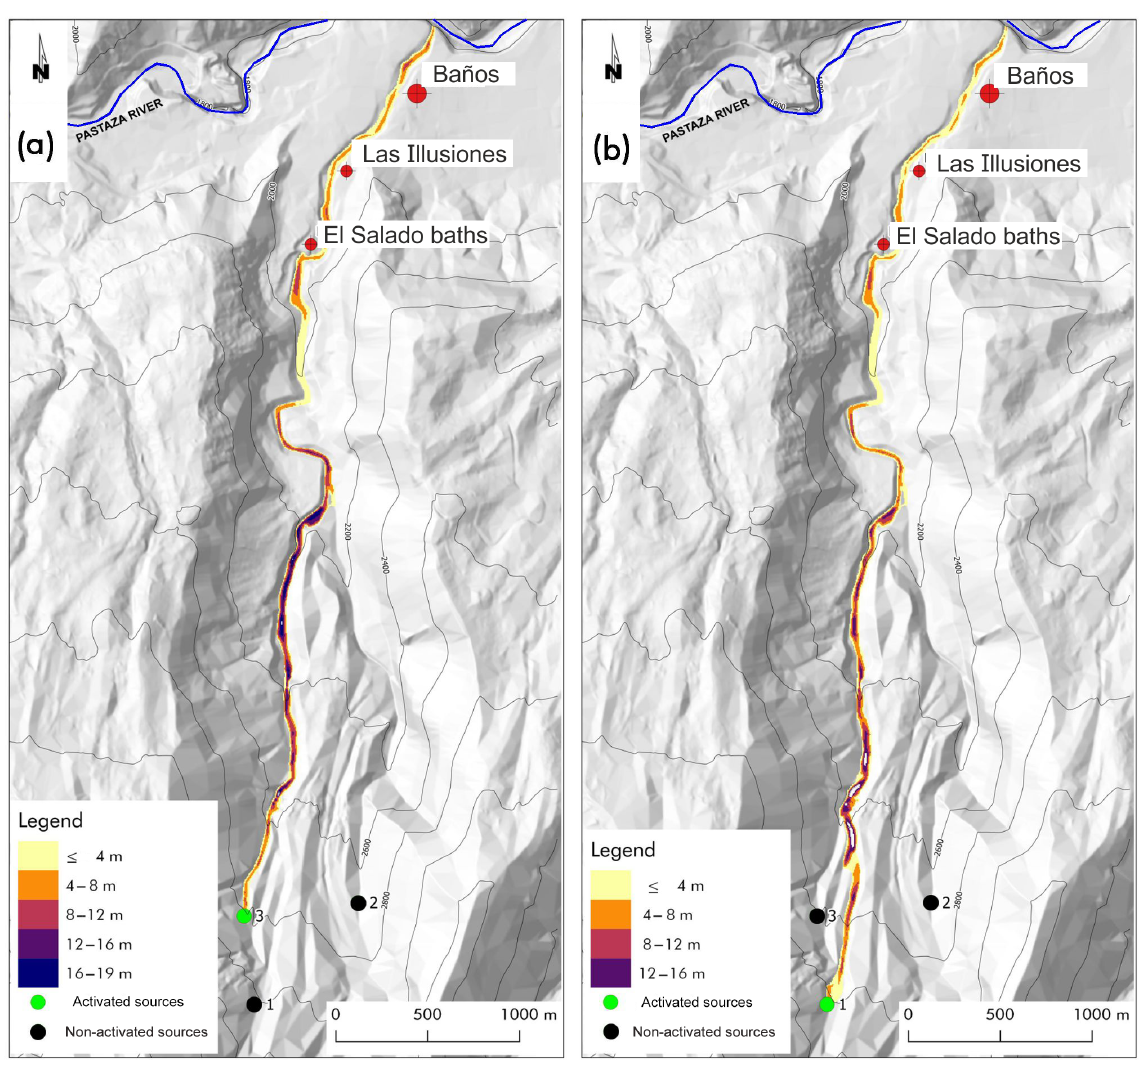
Figure 11. Simulations of deferred triggering of lahars generated in point 3 (a) and 1 (b) . The legend specifies the maximum thickness of the lahar reached during the conjectured events for each point